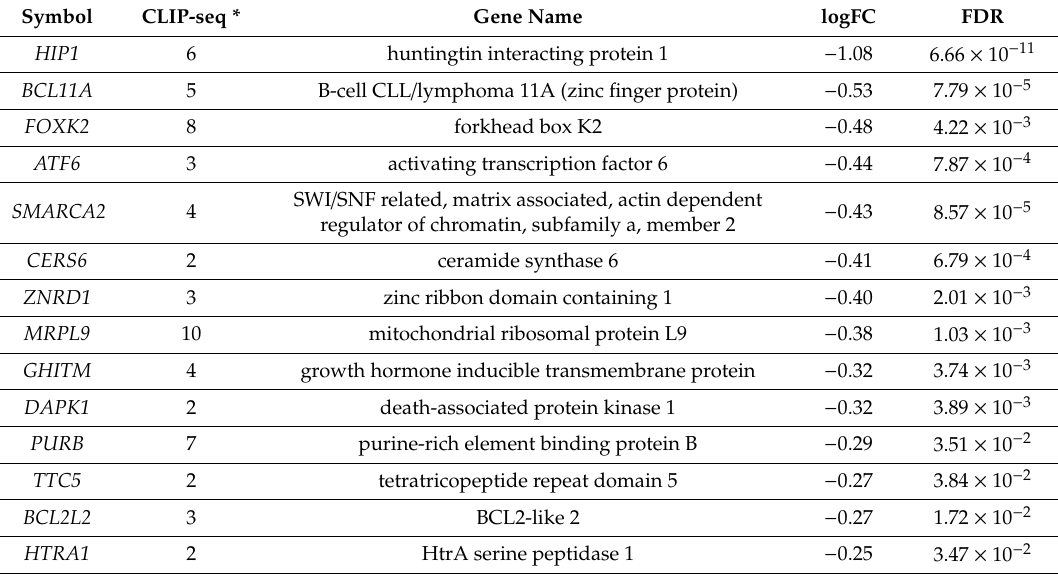
Table 1. Fourteen bona fide miR-1272